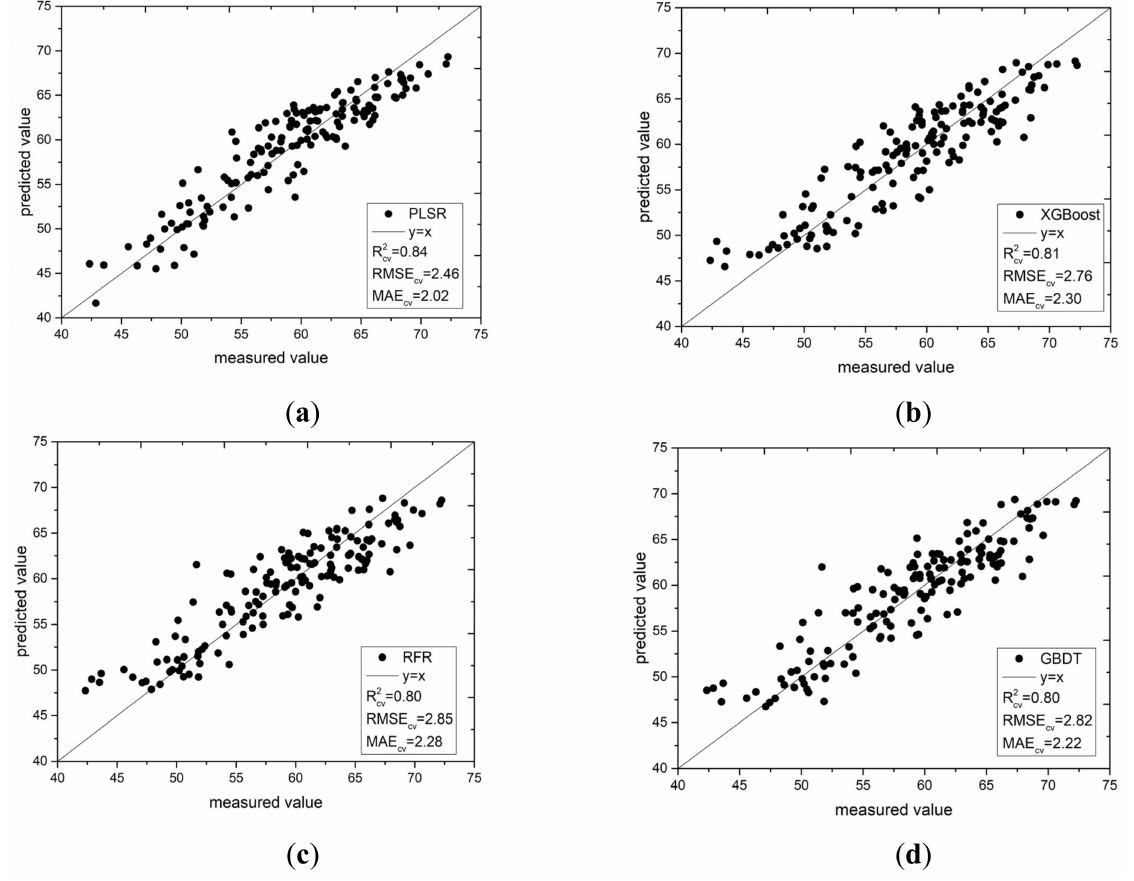
Figure 10. Scatter plot of measured and predicted values of the four models: ( a ) PLSR; ( b ) XGBoost; ( c ) RFR; and ( d )